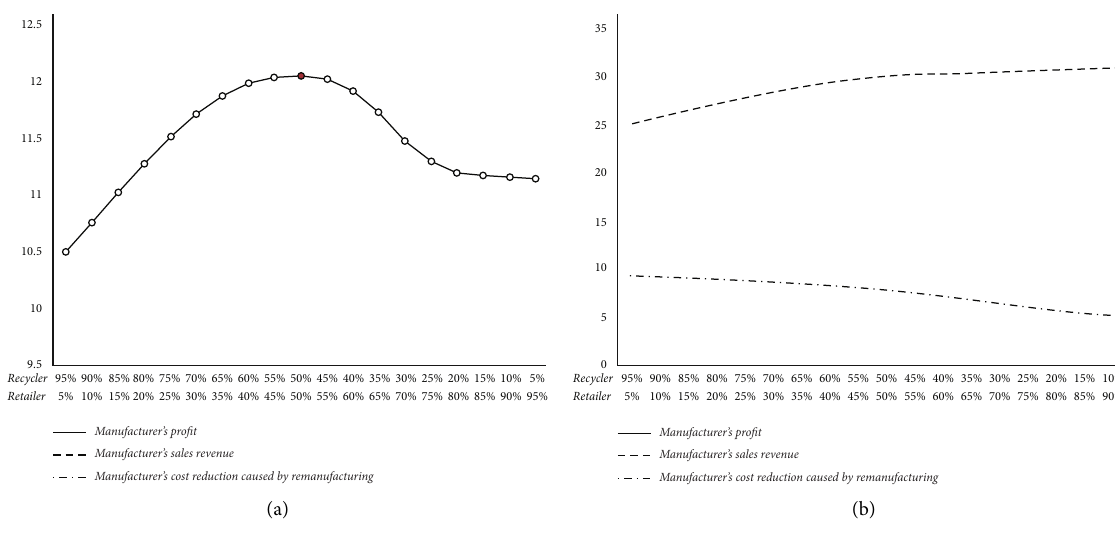
Figure 6: A graphical presentation of the results for the revenue-sharing strategy ( s � 0.65, k �